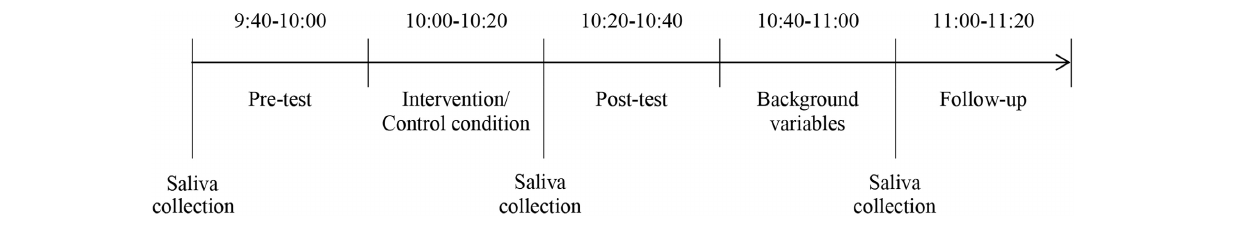
FIGURE 1 | Timeline of the study